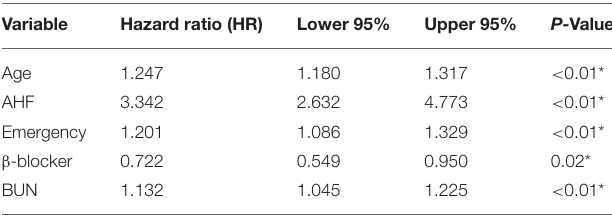
TABLE 2 | Collinearity diagnosis results of five selected variables. Variable